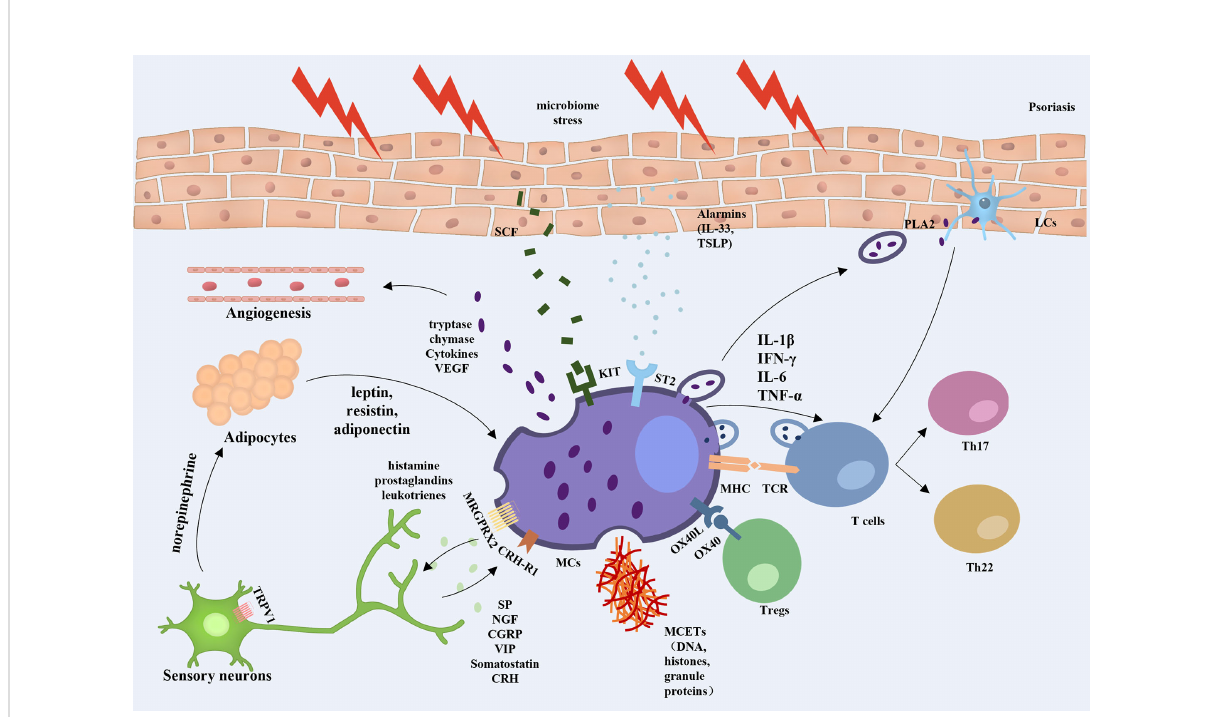
FIGURE 1 Overview of mast cell involvement in psoriasis. When exposed to external stresses, stimulated keratinocytes can promote angiogenesis and amplify in fl ammation by releasing alarmins to trigger ST2-positive MCs secreting TNF and VEGF, etc. The skin microbiota induces keratinocytes to produce more SCF, which bind to the c-kit and are involved in the recruitment and regulation of dermal MCs. MCs can activate T lymphocytes and strengthen Th17 and Th22 responses by interaction with TCR, secretion of extracellular vesicles, and formation of MCETs. MCs also regulate Treg function through the OX40/OX40L axis. Activated MCs were found to increase the sensitivity of TRPV1 in peripheral neurons by releasing nociceptive and pruritogenic mediators. While the stimulated nerve fi bers release CRH and neuropeptides, which induce the activation of MCs via CRH-R1 and MRGPRX2 on the MC surface in a feedback manner. In addition, nerve fi bers release norepinephrine into adipose tissue to regulate the secretion of leptin, resistin, and lipocalin in adipocytes, which promote the conversion of MCs to